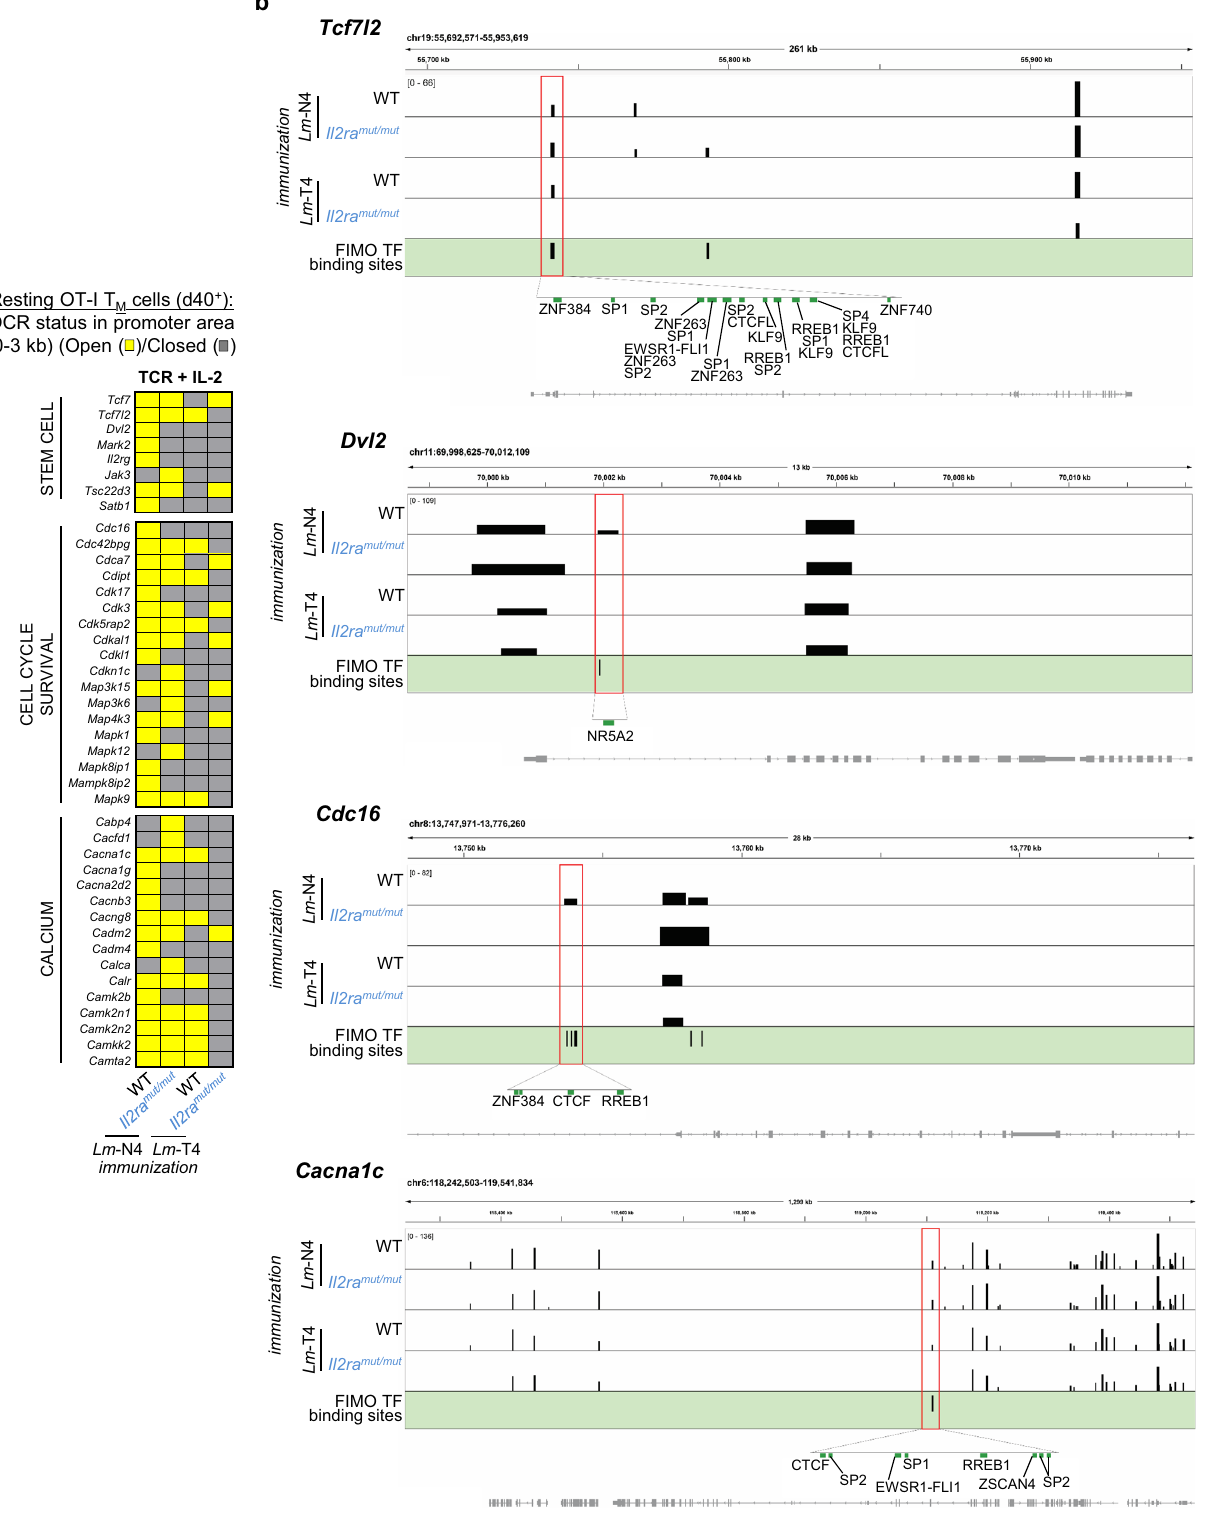
Fig. 7 Chromatin accessibility and predicted TF binding in promoter areas of stem cell, cell cycle and calcium fl ux-related genes of memory CD8 + T cells primed under distinct strengths of TCR and IL-2 signals. a Heat map shows unique OCRs (yellow) in genes encoding stem cell-related proteins, cell cycle/proliferation and calcium fl uxes that were indicated in Fig. 6b when TCR and IL-2 signals were modulated together, in the promoter area and close to the TSS (±~3 kb). Chromatin region status (open, yellow/closed, gray) in WT and Il2ra mut/mut OT-I memory cells primed with Lm -N4 or Lm -T4 are reported. b Selected examples of genes ( Tc fl 2, Dvl2, Cdc16, Cacnac1 ) with differential OCRs (red box) in these OT-I memory CD8 + T cells. Higher magni fi cations of the OCRs show FIMO-predicted binding sites for indicated